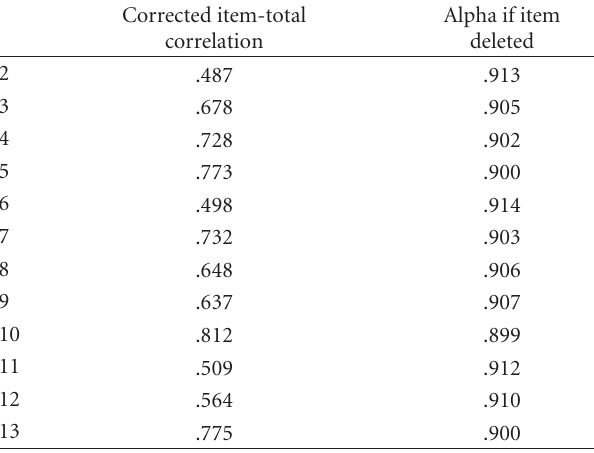
Table 8: Discriminatory power and Cronbach α for each item (second